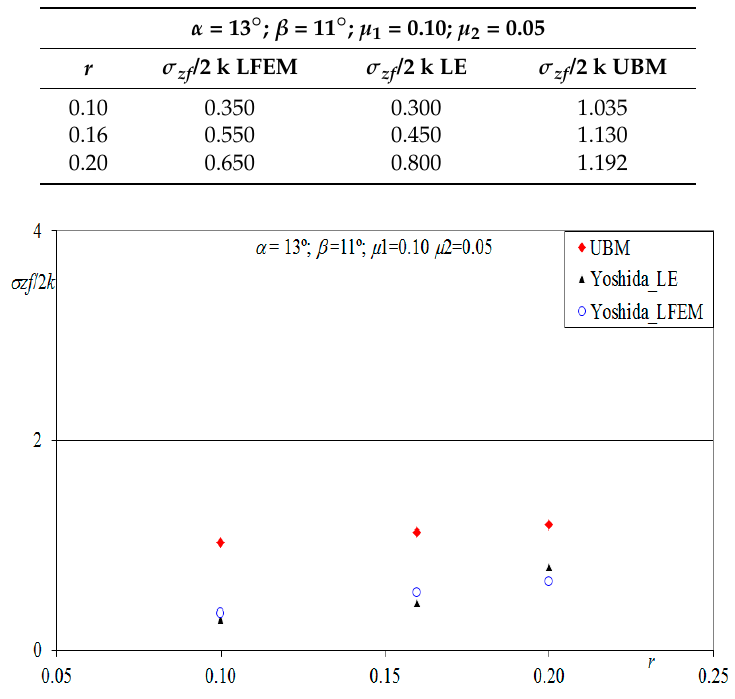
Figure 11. UBM model validation by literature FEM simulations (LFEM) and literature experimental values (LE) taken as parameters values: r = 10%–20%; α = 13°; β = 11°; μ 1 = 0.10; μ 2 = 0.05 [48].